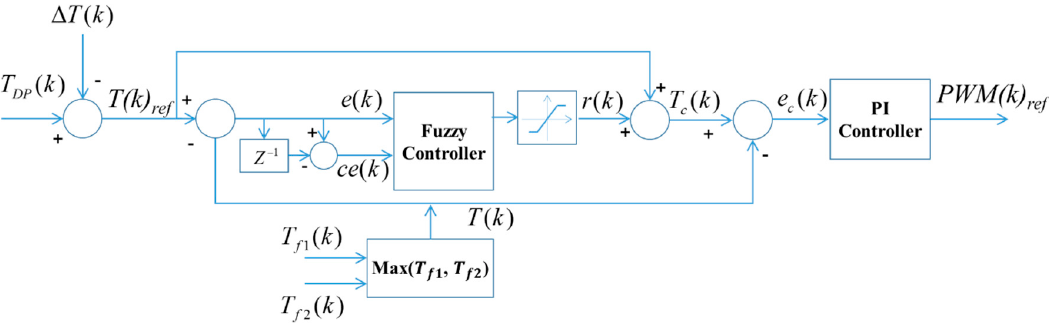
Figure 4. Series connected Fuzzy (SF)-PI controller.